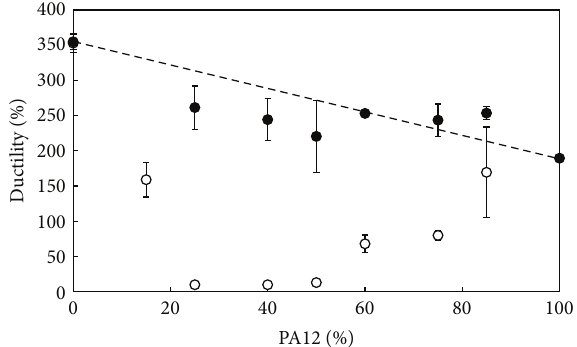
Figure 7: Ductility of the uncompatibilized PP/PA12 ( I ) and com- patibilized gPP/PA12 ( e ) blends, as a function of the PA12